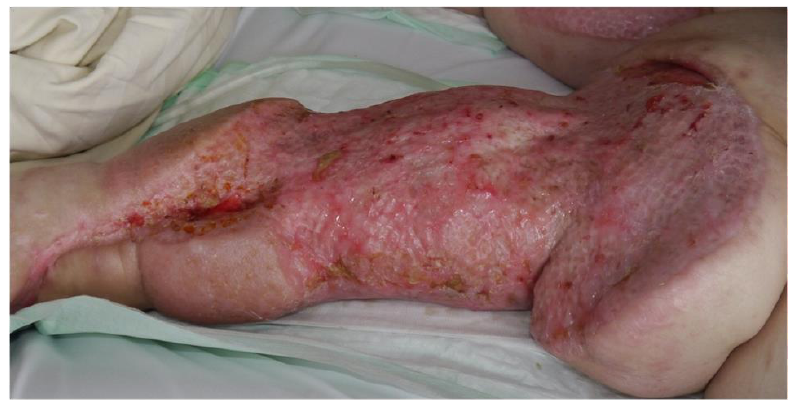
Figure 5. After wound closure by a combined method: Meeks and BSGs.